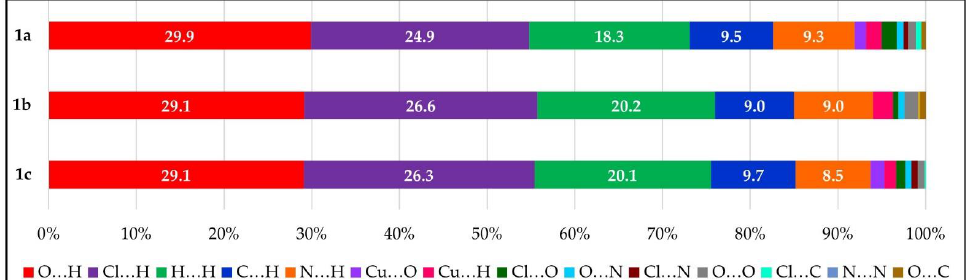
Figure 9. Bar graph, compiling the Hirshfeld surface interactions for 1a – c analyzed by percent contributions of individual atomic contacts.